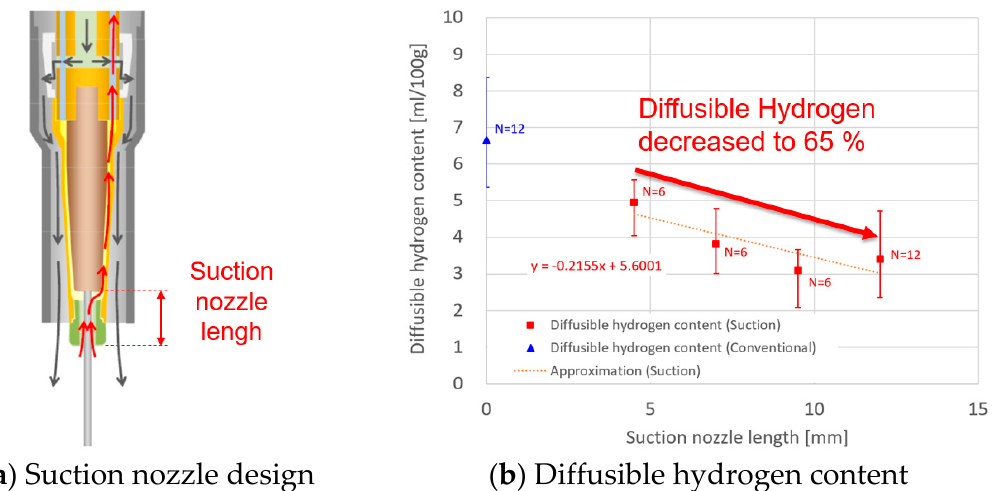
Figure 2. Diffusible hydrogen content measurement: ( a ) suction nozzle design; ( b ) diffusible Figure 2. Di ff usible hydrogen content measurement: ( a ) suction nozzle design; ( b ) di ff usible hydrogen hydrogen content measured as a function of contact tip-to-suction nozzle distance. content measured as a function of contact tip-to-suction nozzle distance.